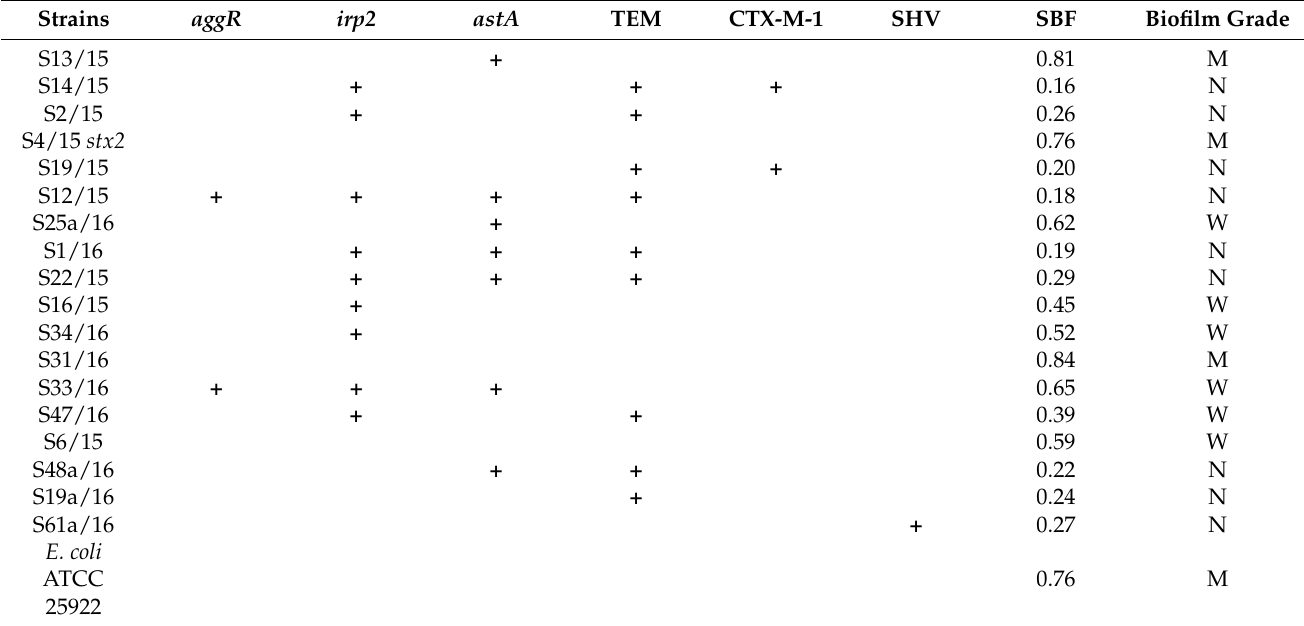
Table 2. Enteroaggregative and ESBL genes and biofilm production of E. coli